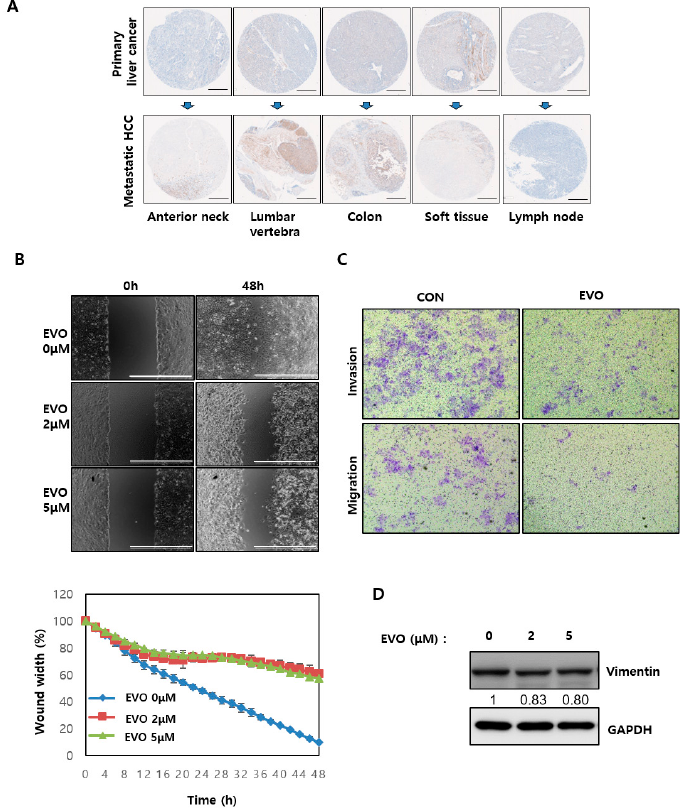
Figure 5. Effects of evodiamine on the metastatic ability of HCC. ( A ) Cancer patient-derived microarrays containing primary HCC and its metastatic HCC tissues were examined for YAP expression. Staining results were graded according to the intensity and proportion of positive cells as described in ‘Materials and Methods’. Scale bar = 500 μ m. ( B ) Hep3B cells were scrapped and incubated with 0, 2, and 5 μ M EVO for 48 h. The scrapped scratches were imaged using an optical microscope. The data are expressed as the percentage of wound width. Scale bar = 1000 μ m. ( C ) Hep3B cells were treated with 5 μ M EVO for 24 h and plated on transwell coated with matrigel (invasion) or without matrigel (migration). ( D ) Hep3B cells were treated with the indicated concentration of evodiamine for 48 h, followed by immunoblotting analysis with vimentin and GAPDH antibodies. The numbers under the western blot indicate the intensity of the band. CON, control; EVO, evodiamine. 3. Discussion HCC is one of the most common cancers with high mortality [26]. Only 15% of pa- tients with HCC can undergo a surgical resection, and liver transplantation is considered a potentially curative approach [26]. The majority of patients proceed to advanced disease. In advanced disease, conventional sorafenib is the only treatment; however, its efficacy is limited by the development of resistance [2]. In addition, the metastasis of HCC is a critical cause of poor prognosis. Thus, exploring additional drugs available for advanced HCC